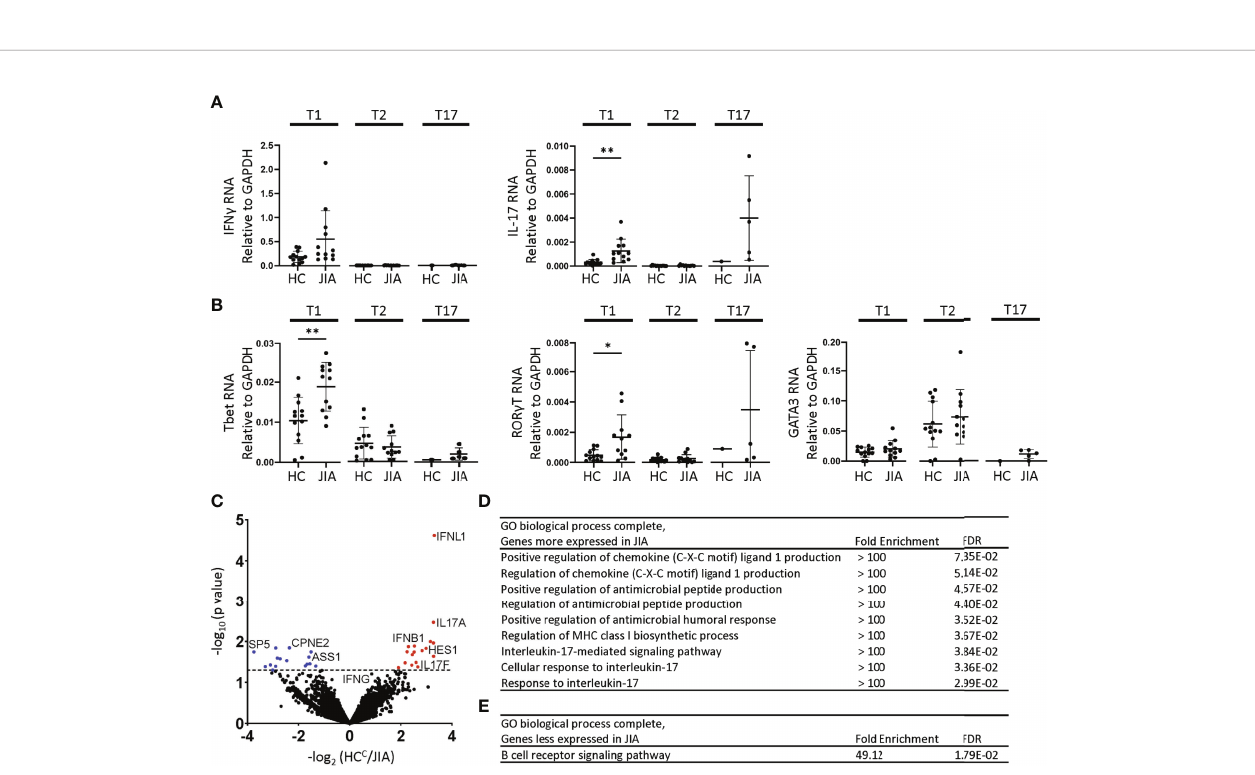
FIGURE 3 | Altered gene expression and T1 biologic pathway activation in JIA. RNA expression in child healthy control (HC) and JIA T1, T2, and T17 cells using RT- PCR for (A) IFN g , IL-17 and (B) Tbet, ROR g T, and GATA3. JIA T1 and T2 (N=12), HC T1 and T2 (N=13). JIA T17 (N=5) and HC T17 (N=1). Analysis by Welch ’ s t-test with *p<0.05, **p<0.01 for T1 and T2 comparisons. (C) Volcano plot of differentially expressed genes in HC (N=3) and JIA (N=3) T1 cultures by RNA sequencing analyzed by DESeq2. Genes overexpressed or underexpressed in JIA with p-value <0.05 (above dashed line). PANTHER Overrepresentation Test from the GO Ontology database for genes (D) overexpressed or (E) underexpressed in